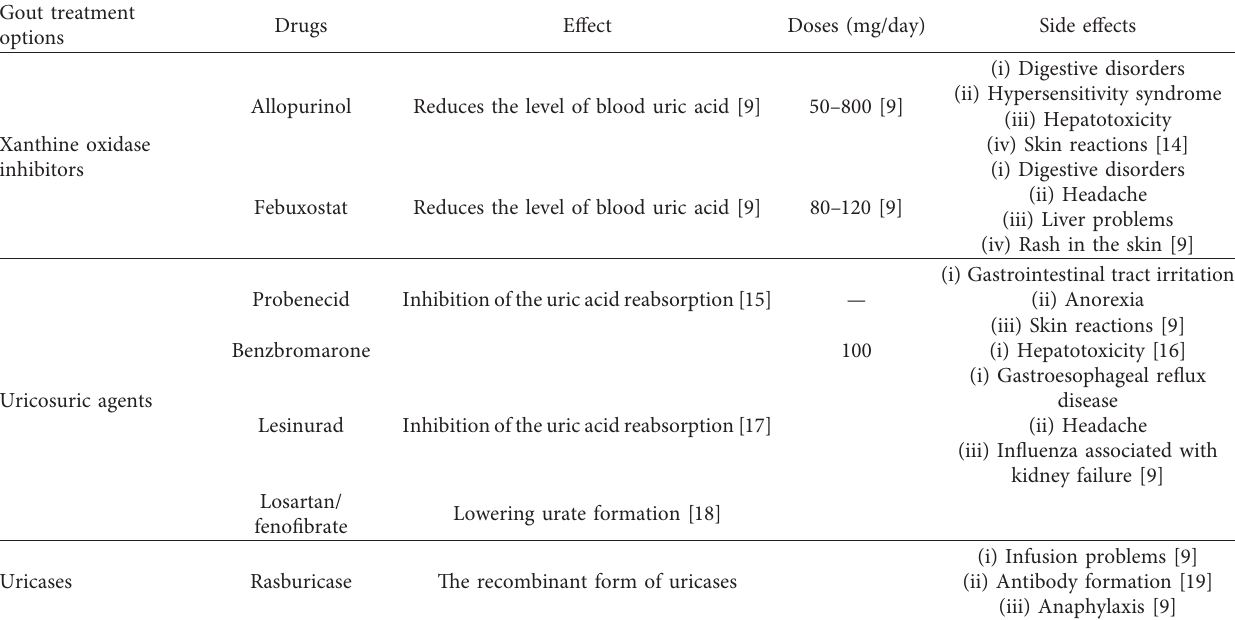
Table 1: The gout treatment drugs and their side